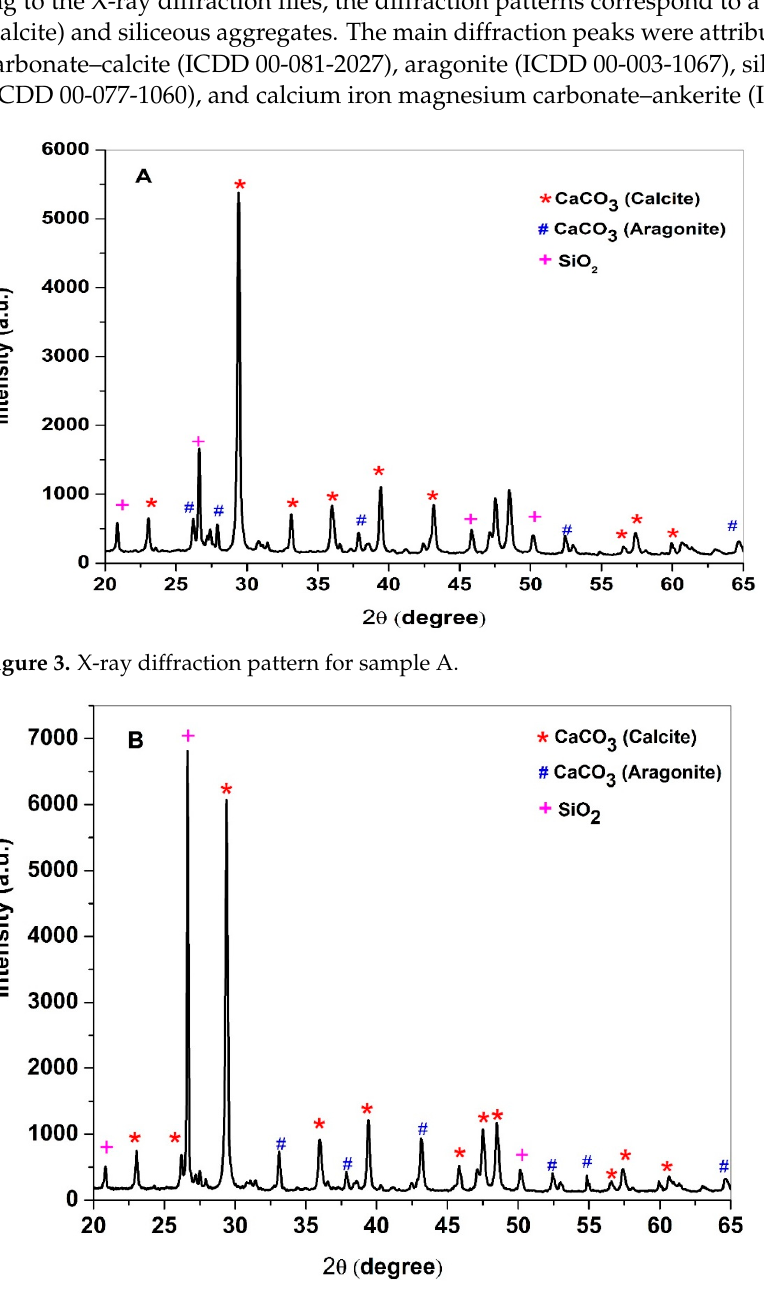
Figure 4. X-ray diffraction pattern for sample B.